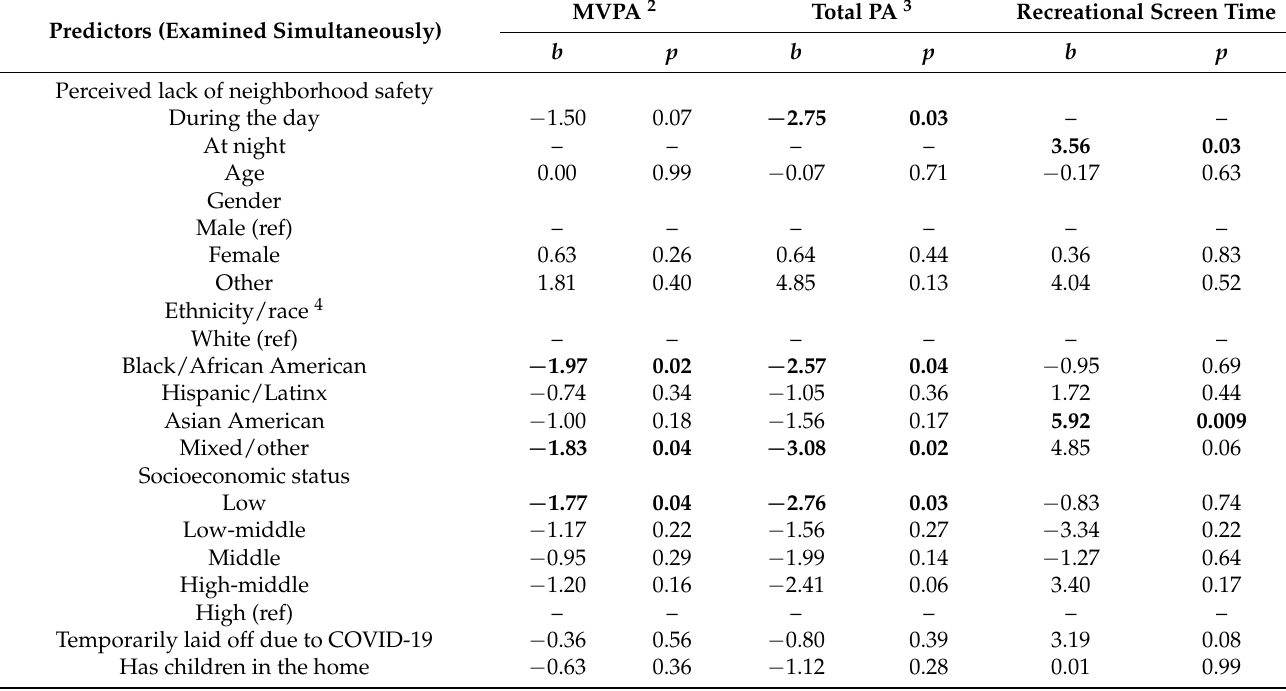
Table 5. Mutually Adjusted Models Examining Predictors of Physical Activity and Recreational Screen Time during COVID-19 Mandatory Stay-at-Home Order 1 . Predictors (Examined Simultaneously)